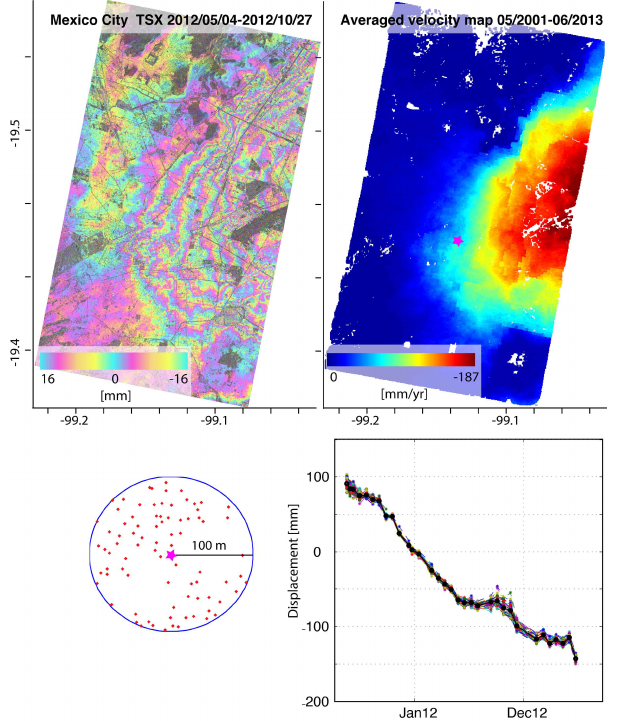
Figure 5. Top left panel: wrapped interferogram showing displace- ment in Mexico City from 4 May to 27 October 2012. Top right panel: averaged velocity map from PS analysis in the study area from mid 2011 to mid 2013. The star shows the location where time series were extracted. Bottom left panel: PS density in a radius of 100m around the point selected. Bottom right: time series of the PS showed in the left panel respect to a master SAR scene from 6 February